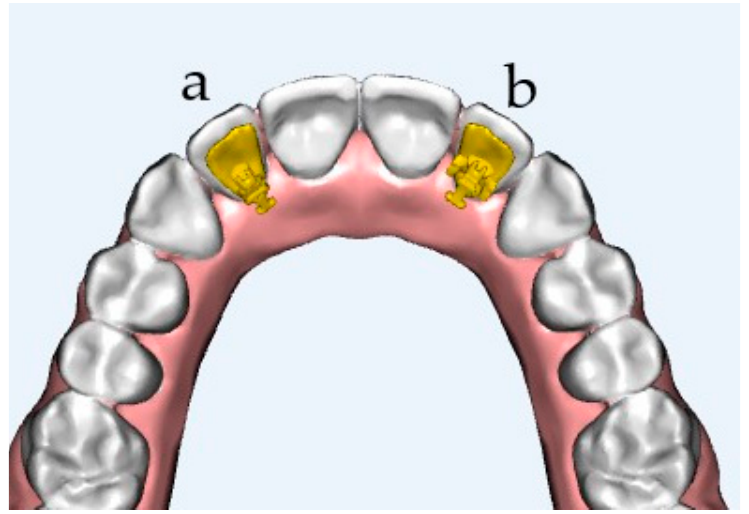
Figure 1. Bracket design ( a ): Incognito™ Appliance System (IAS) and ( b ): Tip-Bar™ System (Incognito, TOP-Service, Bad Essen, Germany).